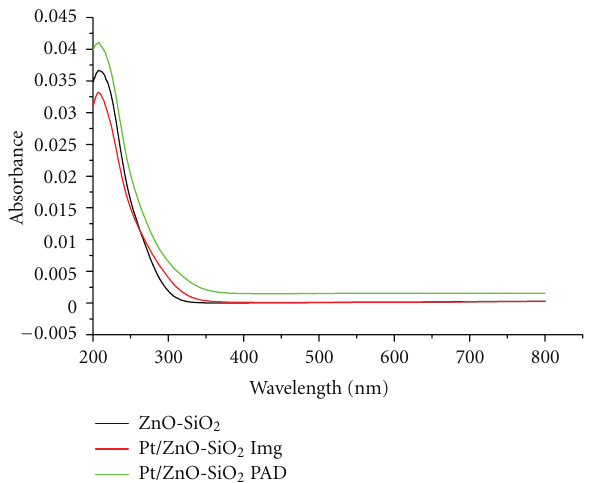
Figure 6: Di ff use reflectance UV-Vis absorption spectra of ZnO- SiO 2 , Img: Pt-ZnO-SiO 2 , and PAD: Pt-ZnO-SiO 2 . properties of the synthesized samples, such as bandgap, surface area, and pore volume, with their catalytic